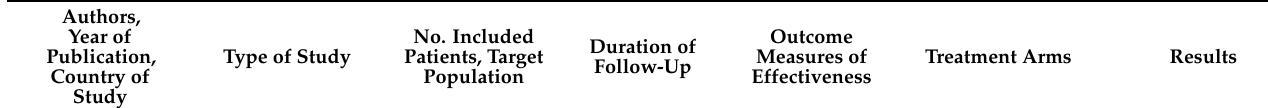
Table 2. Real-world population-based studies investigating the effectiveness of SGAs LAI formula- tions in patients with schizophrenia and related